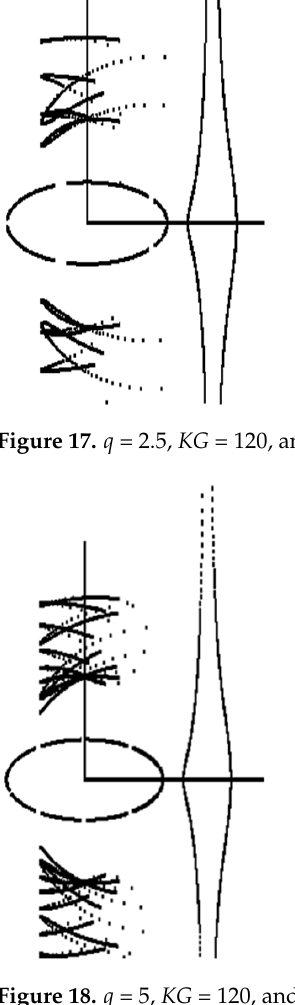
Figure 18. q = 5, KG = 120, and DK = 140.